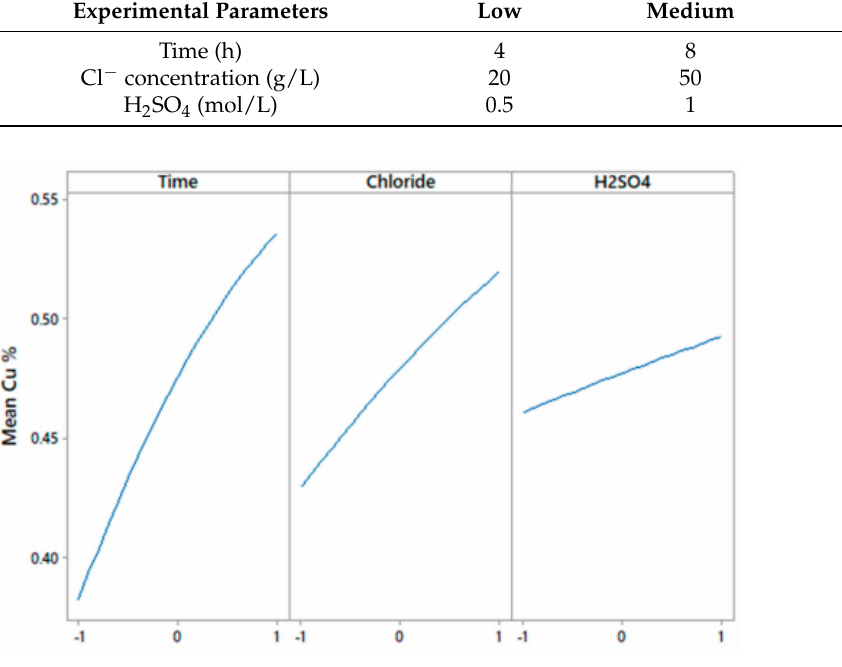
Figure 6. Effect on the H 2 SO 4 concentration in the Cu 2 S solution with the use of wastewater (~40 g/L Cl − ) [46].